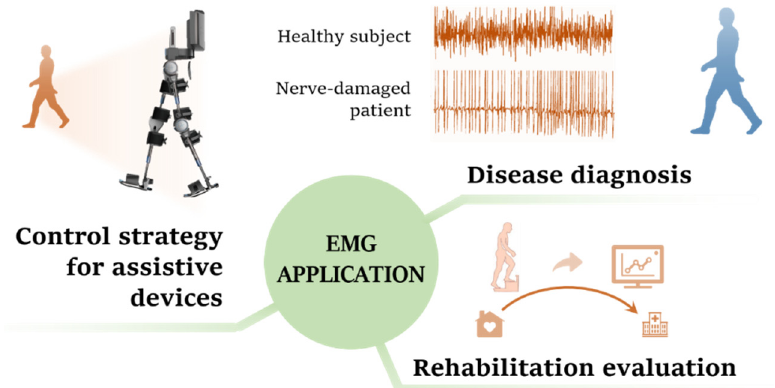
Figure 1. The conceptual depiction of the application scenarios of the electromyography (EMG) pattern recognition technique.